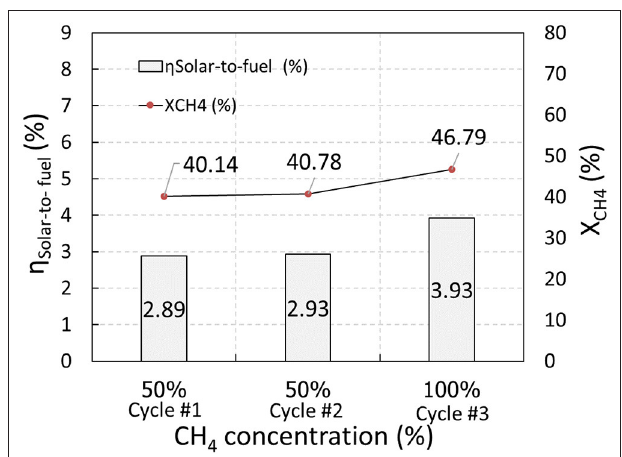
FIGURE 8 | CH 4 conversion and solar-to-fuel efficiency as a function of inlet CH 4 concentration at 1,000 ◦